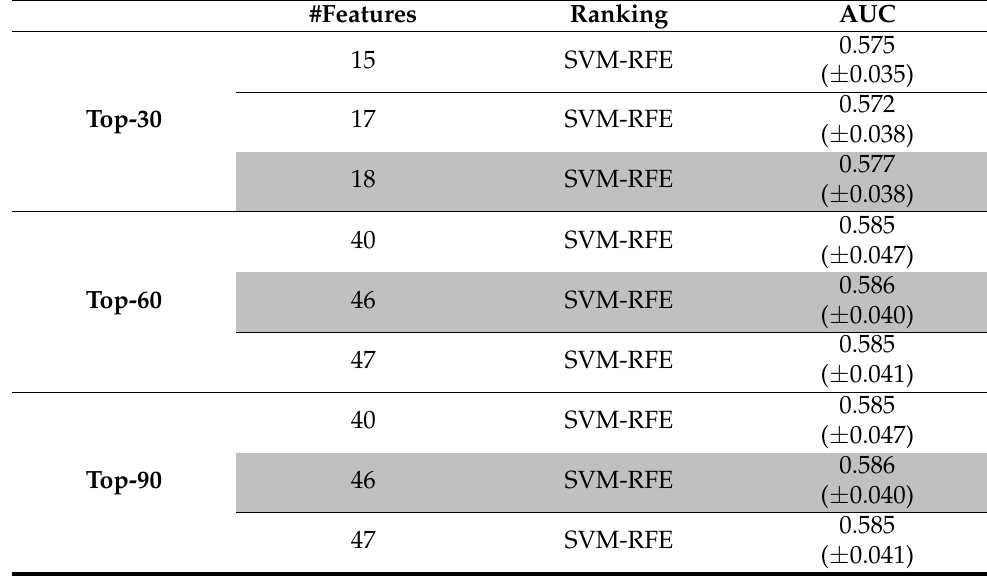
Table 4. k-NN classifier. In gray background the number of features with the best result.